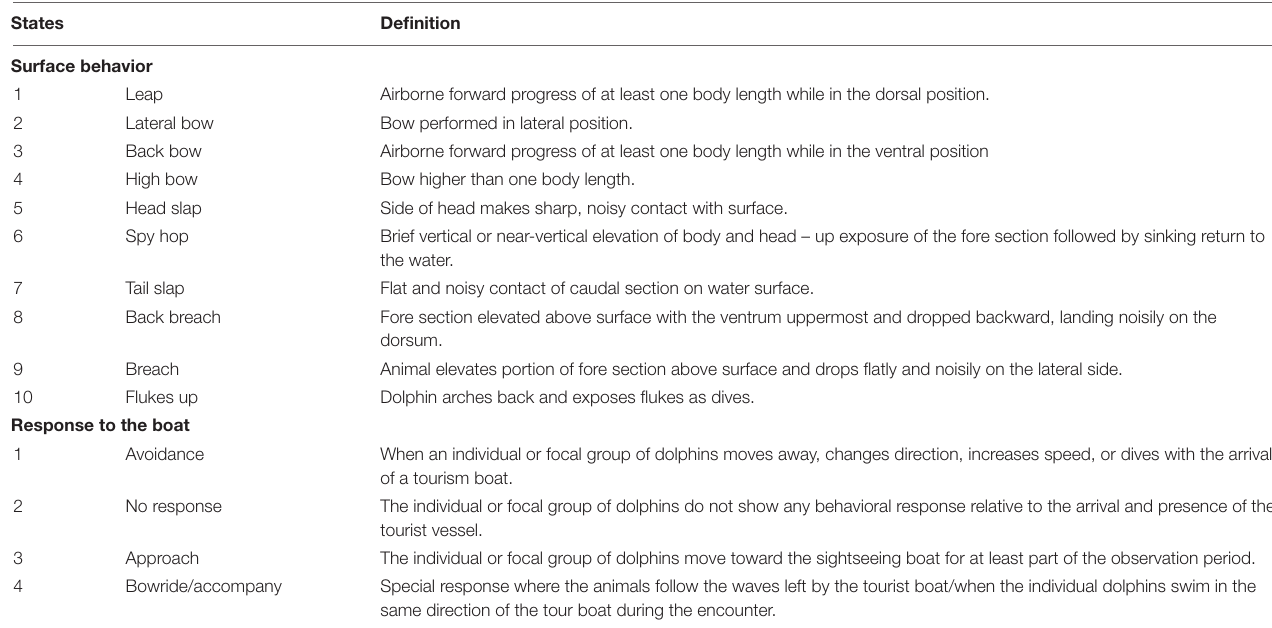
on trips lasting 2–3 h between January and February, with two